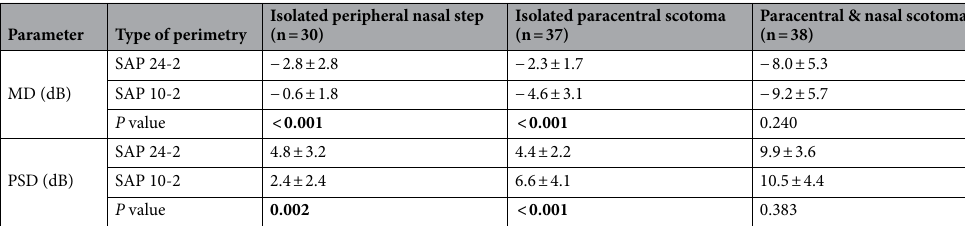
Table 2. Mean deviation and pattern standard deviation of standard automated perimetry in glaucoma patients. Statistically significant values ( P < 0.05) are shown in bold. MD, mean deviation; PSD, pattern standard deviation; SAP, standard automated perimetry. *Differences between the SAP 24-2, SAP 10-2 were compared by paired